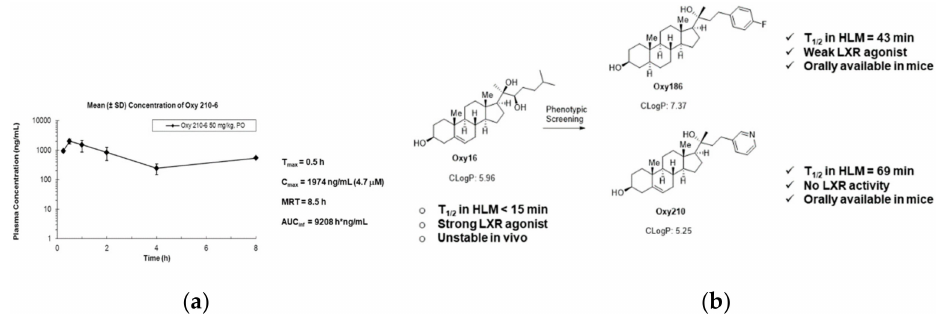
Figure 13. Drug-like properties of Oxy210. ( a ) A single dose of Oxy210 at 50 mg / kg, formulated in 3% DMSO + 7% Ethanol + 5% PEG400 + 85% corn oil, was administered to balb / c mice by oral gavage. Plasma samples were taken at 10 min, 30 min, 1h, 2h, 4h, 6h, and 8h, followed by LC / MS analysis of the plasma. ( b ) Evolution of Oxy210 and Oxy186 from parent compound Oxy16 and their drug-like properties. Table 1. Metabolic Stability in human and mouse liver microsomes (HLM, MLM). Compound